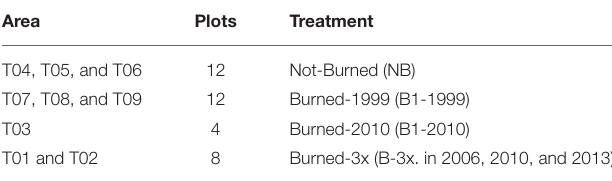
TABLE 1 | Area characteristics of burned and unburned forests and number of plots sampled (T01–T09) in Mato Grosso, southern Amazonia, Brazil.